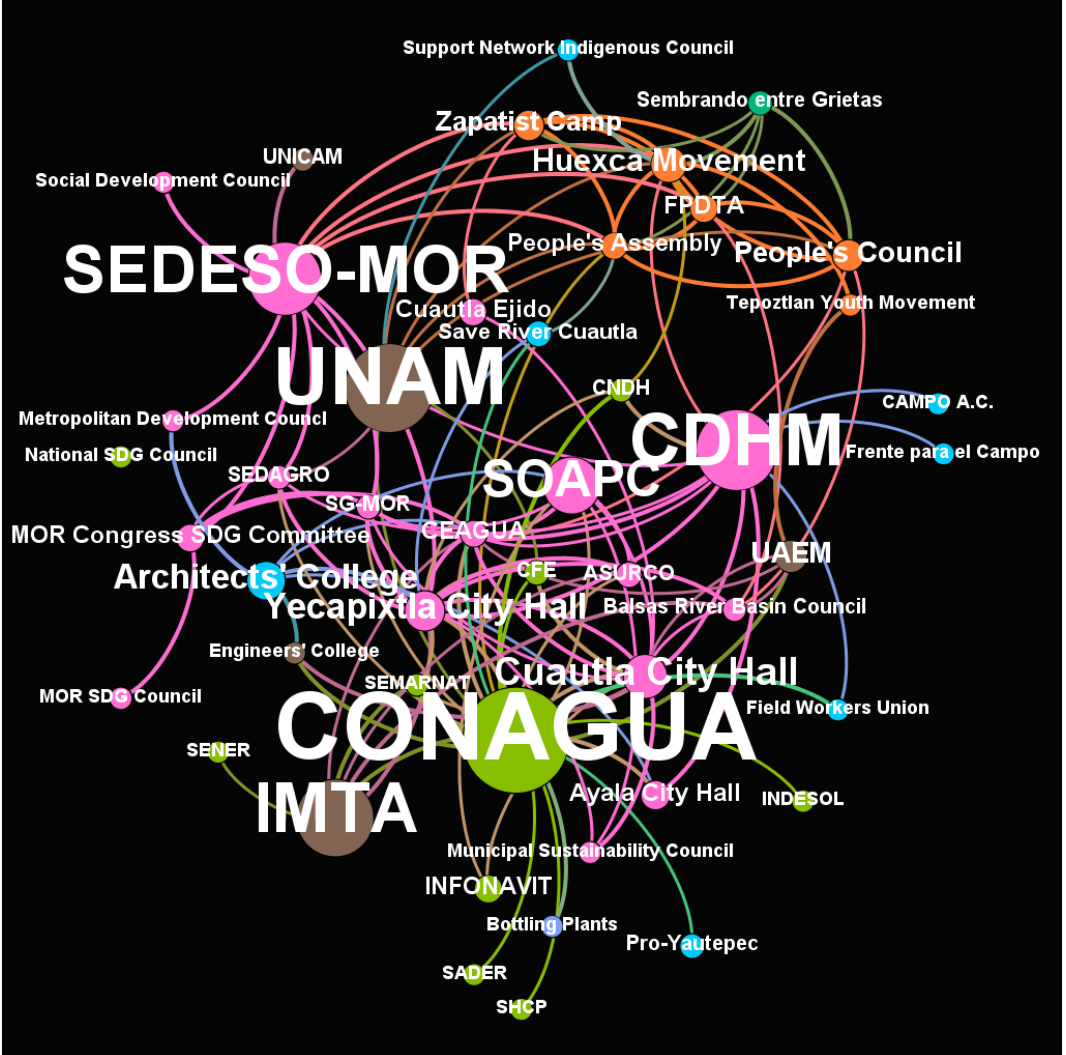
Figure A1. Network of frequent (monthly to quarterly) communication between WEF-Nexus actors.